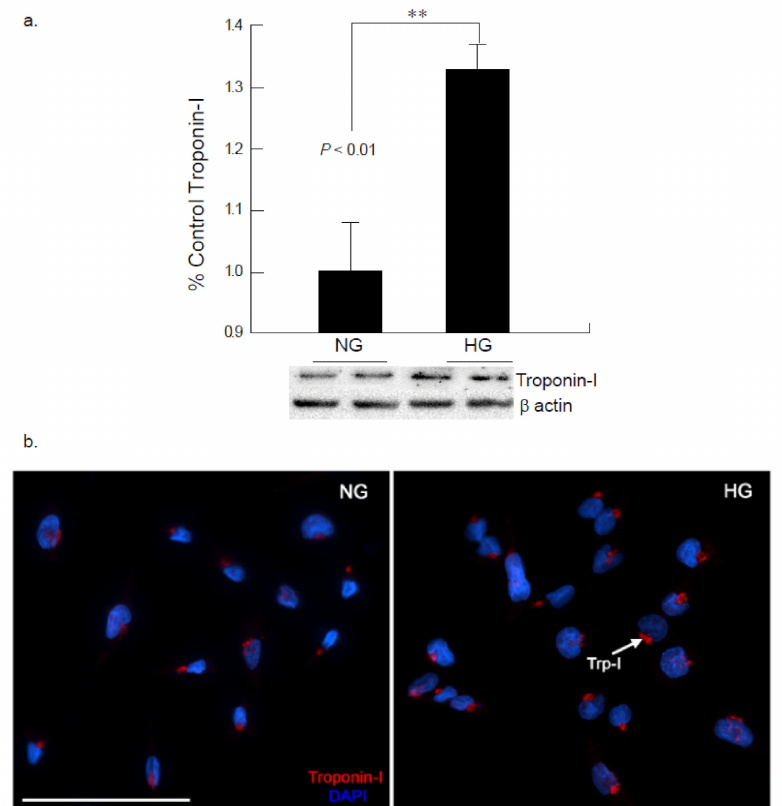
Figure 2. Hyperglycemia mediates increased Troponin I expression in the cardiomyocytes. ( a ) West- ern blot analysis of AC16 cardiomyocytes given hyperglycemic insult for 24 h showed an increase in the expression of Trp-I as compared to cells exposed to normal glucose (NG; ** p < 0.01). ( b ) Immuno- cytochemical analysis of cardiomyocytes exposed to high glucose (HG) for 24 h showed an increase in the expression of Troponin I (red). (Scale bar = 100 µ